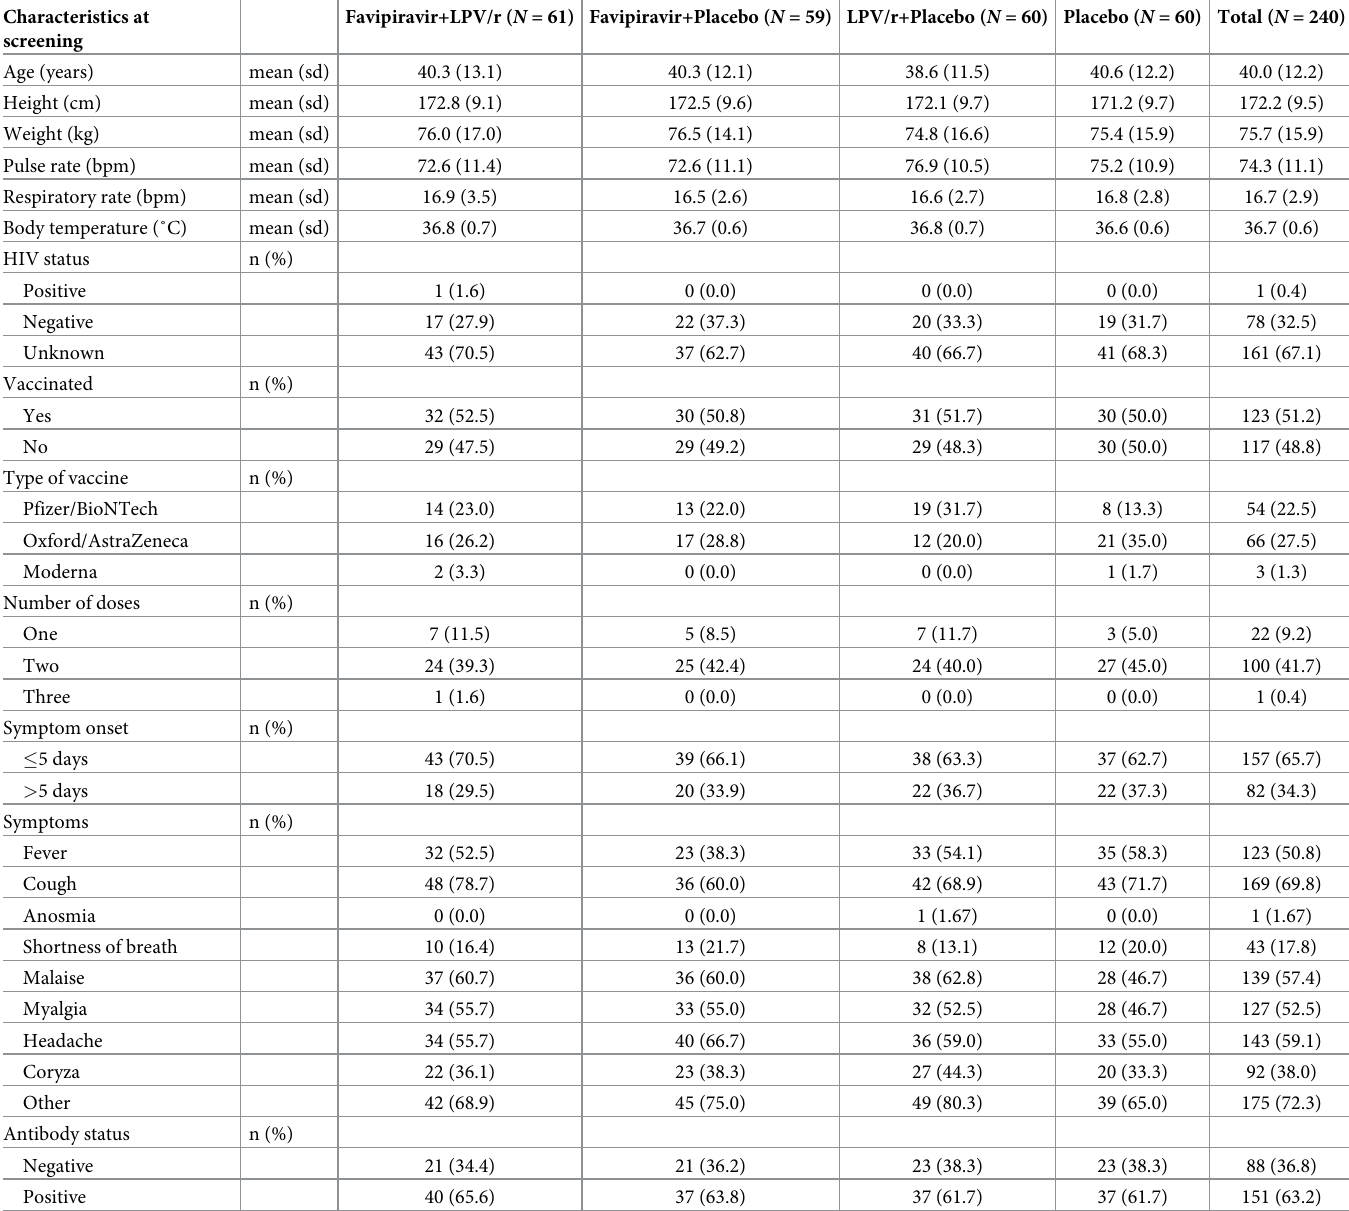
Table 1. Participant baseline